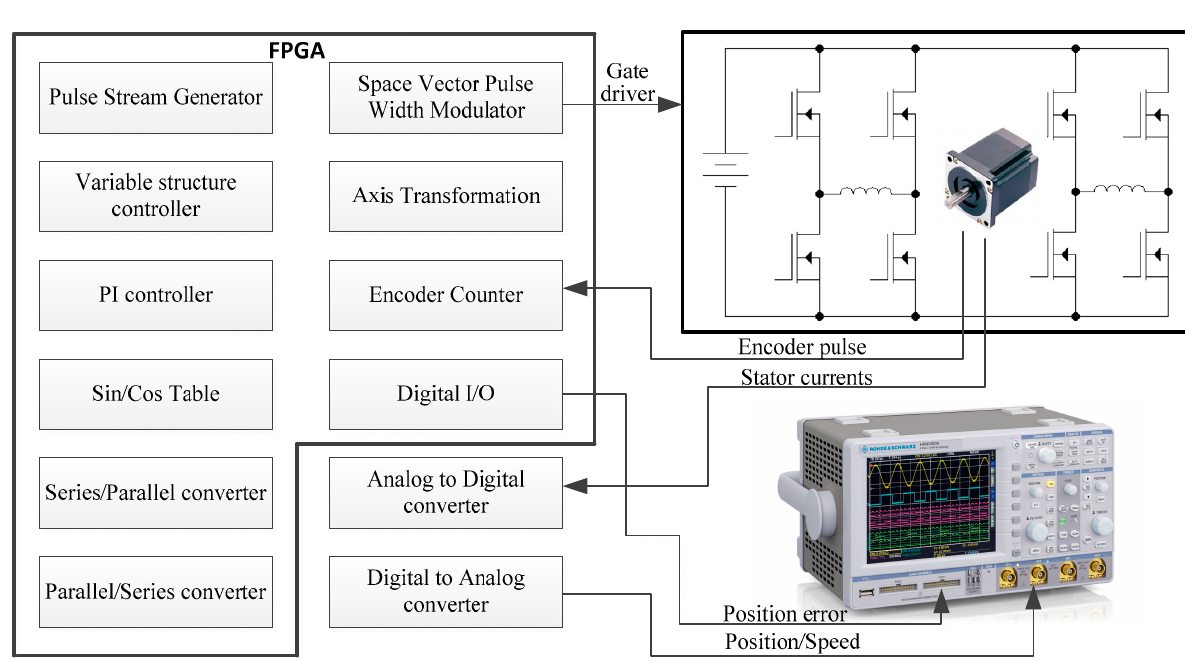
Figure 16. The built functions of FPGA and signal flow diagram of experiment system. The experimental results with step position command input are shown in Figure 17. The system takes about 100 ms to reach its steady-state value as simulated, and the speed response is not so sharp as the simulation. Table 2. The usage of chip to realize the drive system.